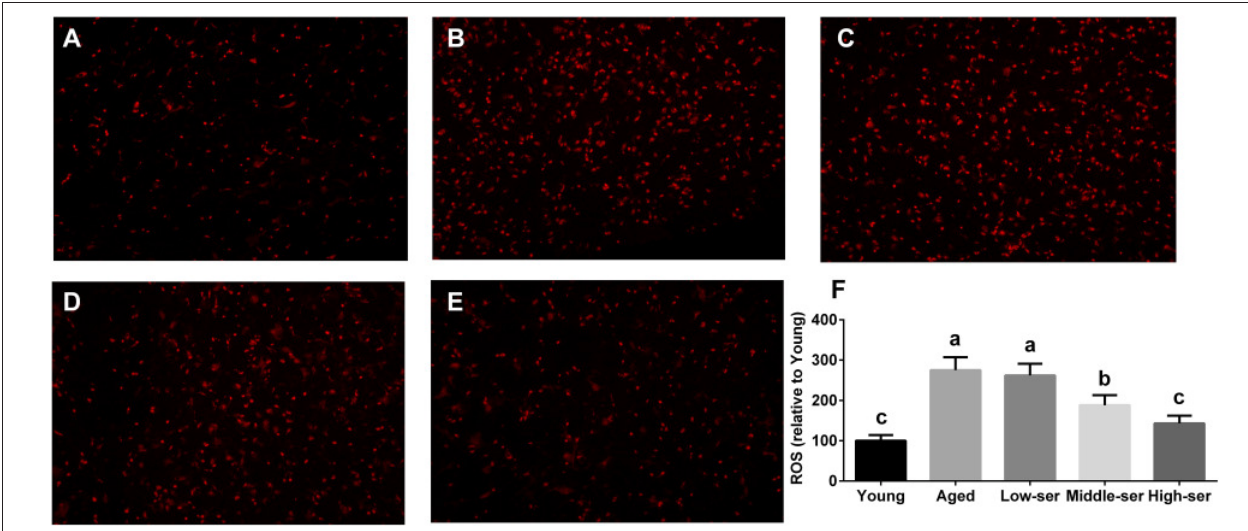
FIGURE 3 | Effects of long-term L -serine administration on the ROS content in aging mice. Representative images of ROS in mice from the Young (A) , Aged (B) , Low-ser (C) , Middle-ser (D) , and High-ser (E) groups; (F) Relative ROS content. Aged, untreated control mice; Low-ser, mice supplemented with 0.1% (wt/vol) L -serine dissolved in the drinking water; Middle-ser, mice supplemented with 0.2% (wt/vol) L -serine dissolved in the drinking water; High-ser, mice supplemented with 0.5% (wt/vol) L -serine dissolved in the drinking water. Young, adult male mice at the age of 18 months. ROS, reactive oxygen species. Values are expressed as mean ± SEM, n = 4. a,b,c Means of the bars with different letters were significantly different among groups ( P < 0.05).